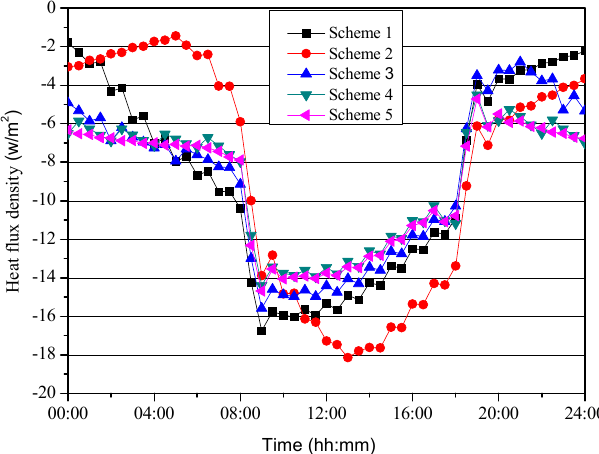
Figure 17. Heat flux densities of the ceiling in the top-floor room with varying distributions of time for cooling. Table 4. Total capacity for cooling of the embedded tubes with varying distributions of the cooling time.